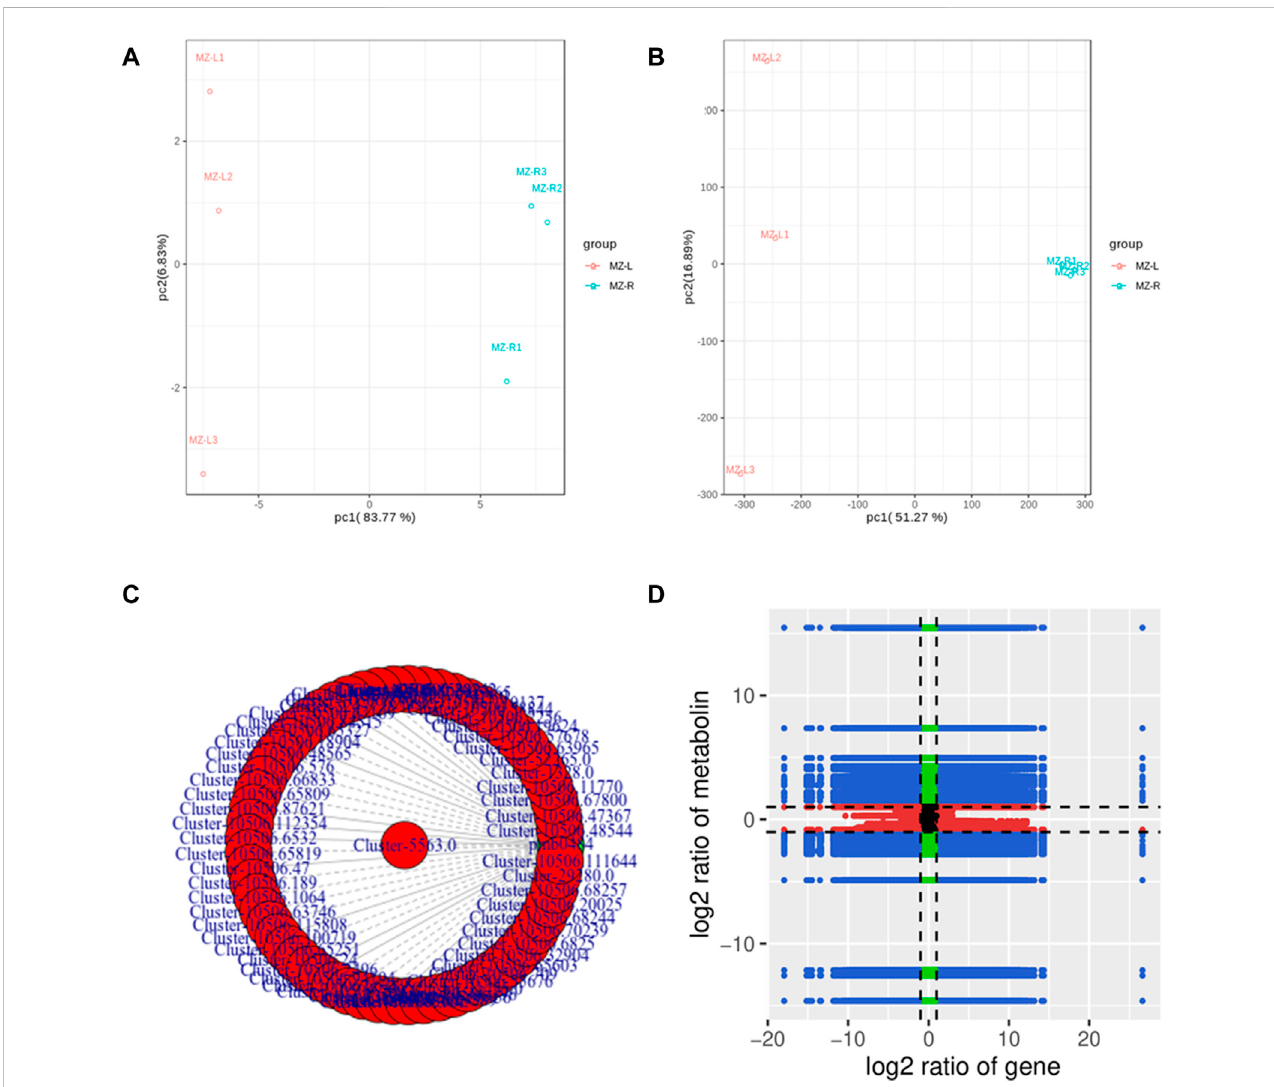
FIGURE 7 PCA and Correlation analysis of genes and metabolites detected by each differential group of samples from V. mengtzeanum (A) PCA of metabolome and (B) PCA of transcriptome data to visualize the differences between the sample groups of V. mengtzeanum in the transcripts and metabolites. (C) Correlation network diagram revealing a correlation between metabolites and genes. The differential genes and metabolites with a correlation value greater than 0.8 in each pathway were selected for plotting. Metabolites are marked in green; genes are marked in red.Solid lines represent positive correlation, and dotted lines represent the negative correlation. (D) Pearson ’ s correlation coef fi cient (PCC) of genes and metabolites through the nine-quadrant chart to showthedifferentmultiplesofgenemetaboliteswithaPCCvaluegreaterthan0.8ineachdifferentialgroup,andablackdottedline,fromlefttorightandfrom top to bottom, dividing the plot into 1 – 9